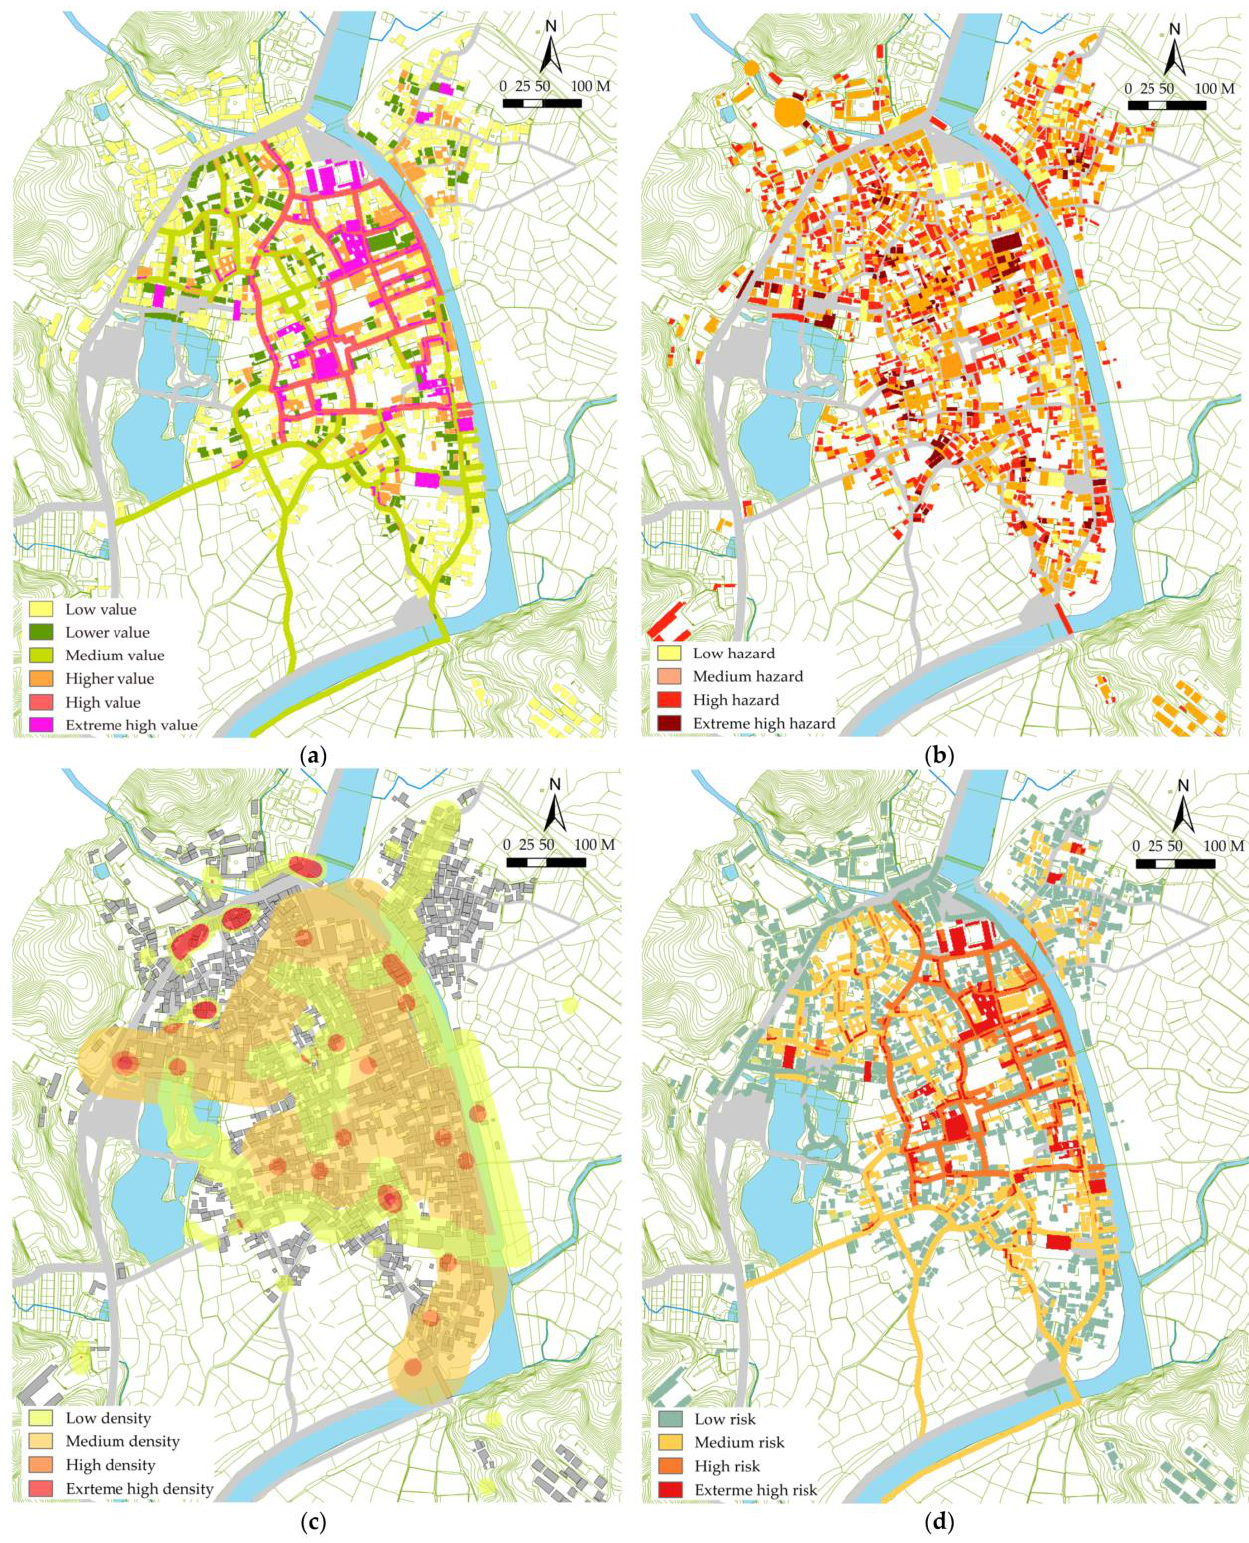
Figure 12. Different aspects of Chengkan Village assessment. ( a ) Cultural relic value sensitivity assessment; ( b ) village fires hazard assessment; ( c ) evacuation accessibility assessment; ( d ) comprehensive fire risk assessment.